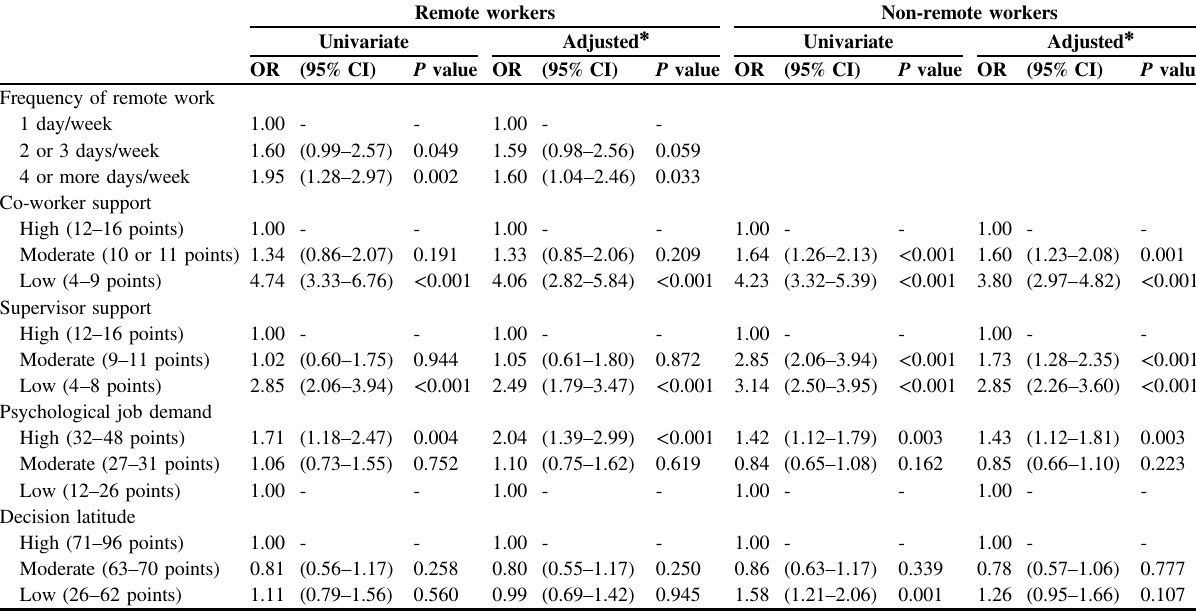
Table 3 Association between job stress and loneliness in remote and non remote workers